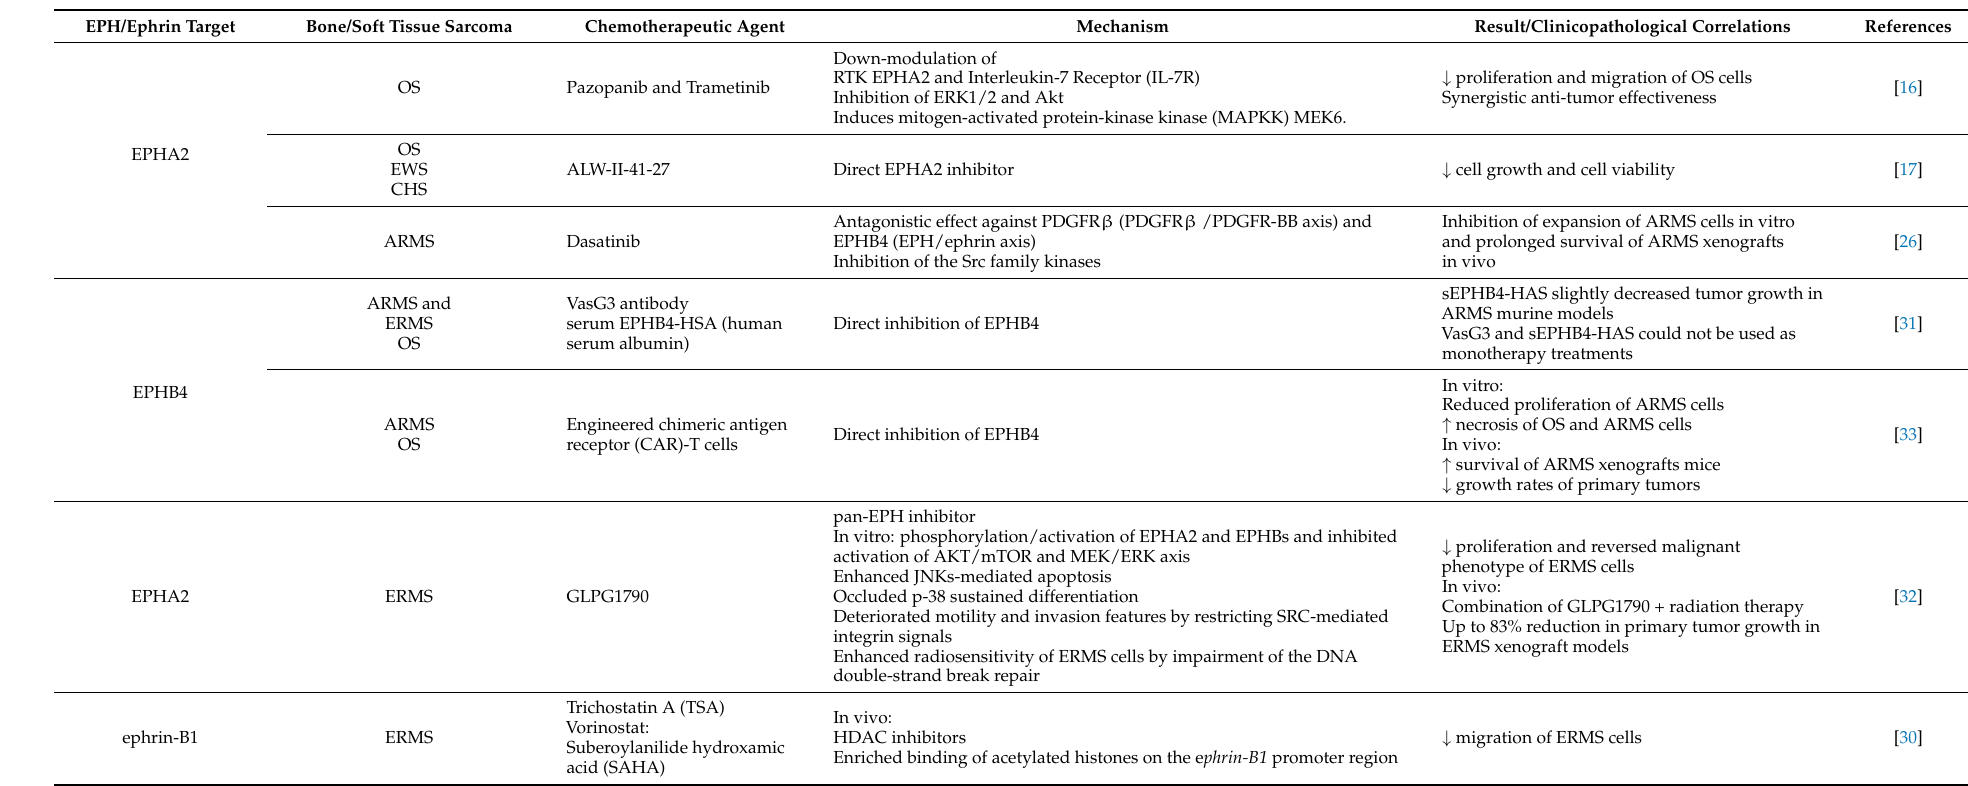
Table 3. Chemotherapeutic agents targeting the EPH/ephrin axis that have been proposed for the treatment of bone and soft tissue